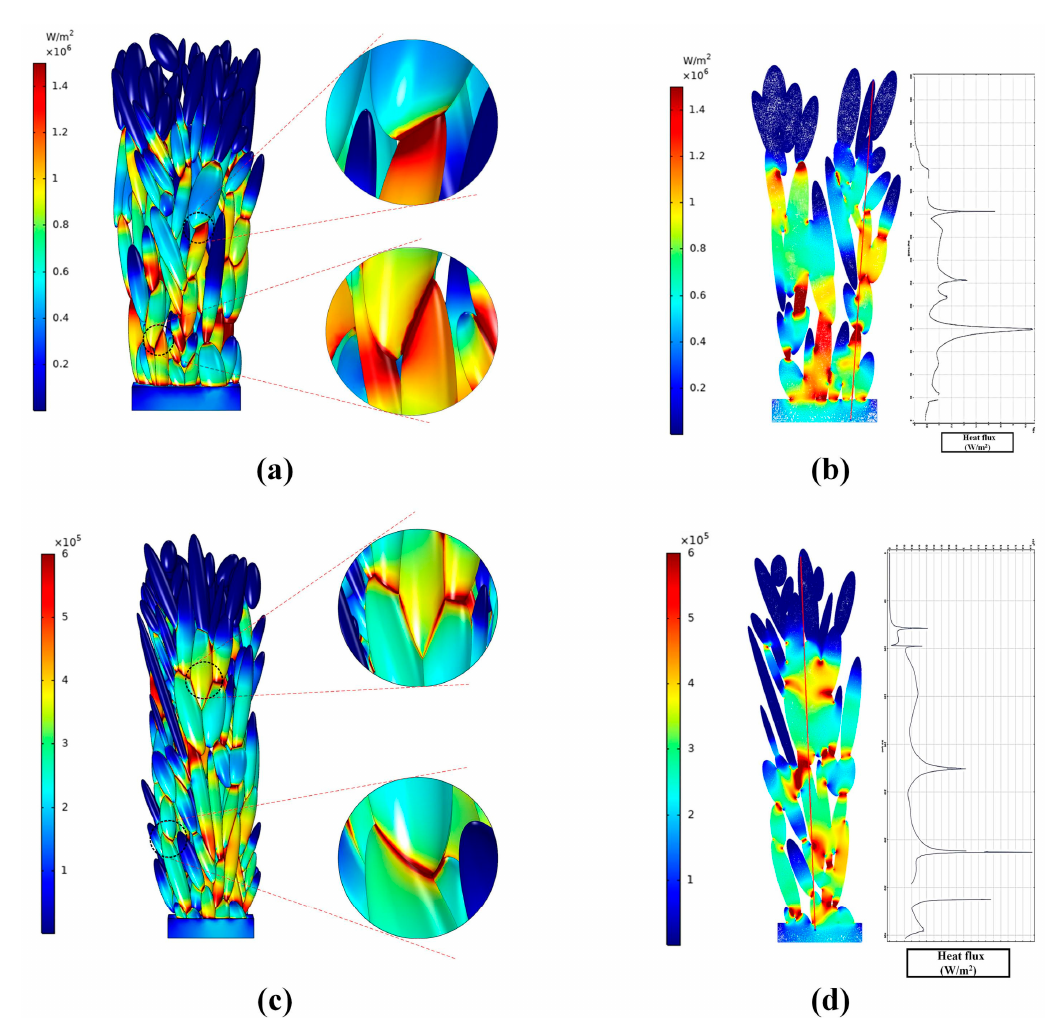
Figure 32. The YSZ coating model: ( a ) heat flux field ( b ) cross-section of heat flux field, the GZO coating model ( c ) heat flux field ( d ) cross-section of heat flux field [173] .